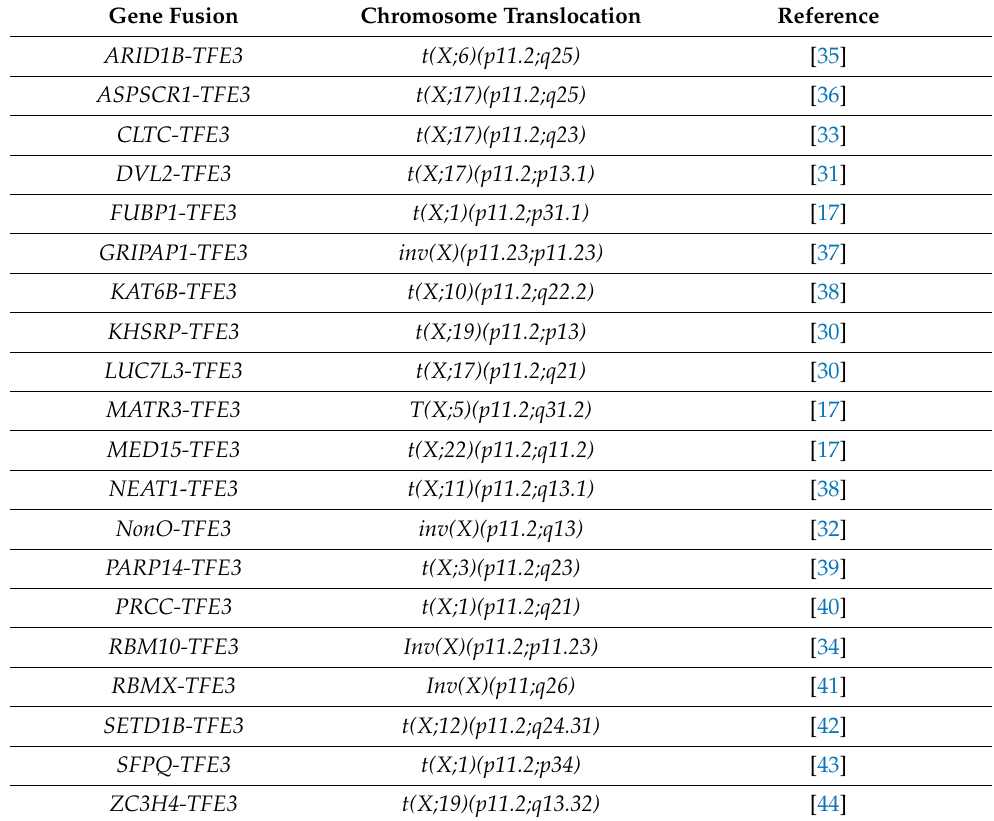
Table 3. TFE3 fusion